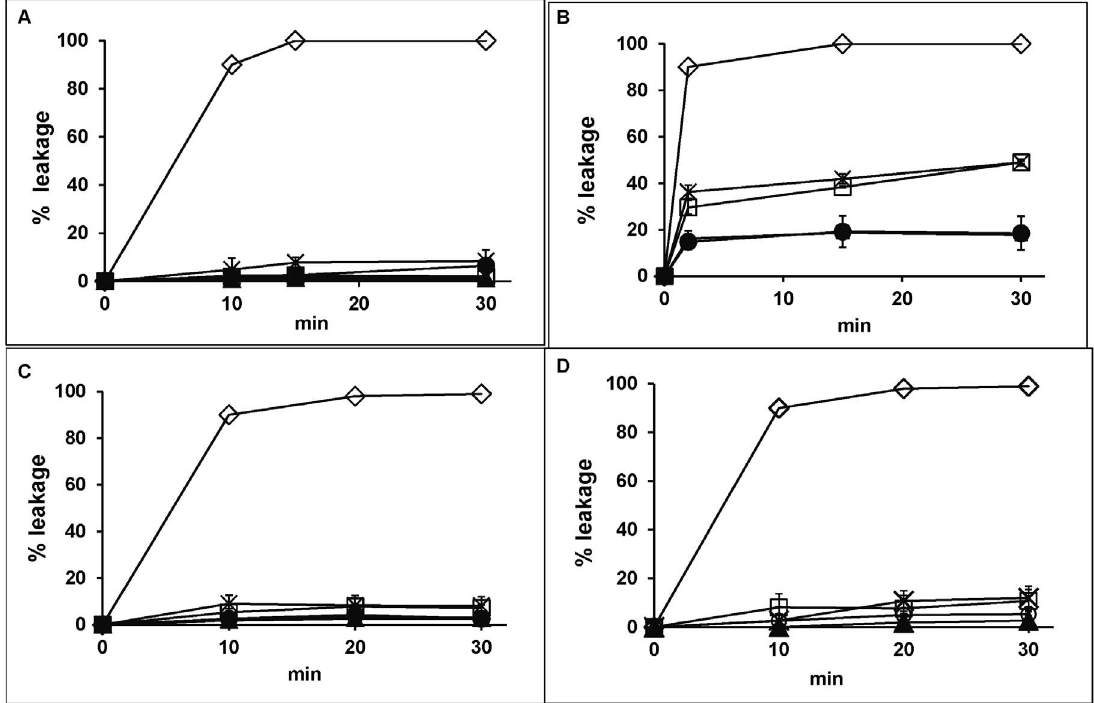
Figure 6. Effect of FG08 on calcein release from SUVs that mimic glyeerophospholipid and sterol compositions of fungal, bacterial, and mammalian cell plasma membranes. Calcein-loaded SUVs made with PC alone (A), or with glycerophospholipid and sterol compositions that mimic fungal (PC/PE/PI/ergosterol [5:4:1:2]) (B), bacterial (PC/PG [7:3]) (C) or mammalian cell (PC/cholesterol [10:1] (D) plasma membranes [12,14] were exposed to FG08 at 5 ( m ), 30 ( % ), and 62.5 ( 6 ) m g mL 2 1 , kanamycin B (62.5 m g mL 2 1 ) ( compiled from three separate experiments.